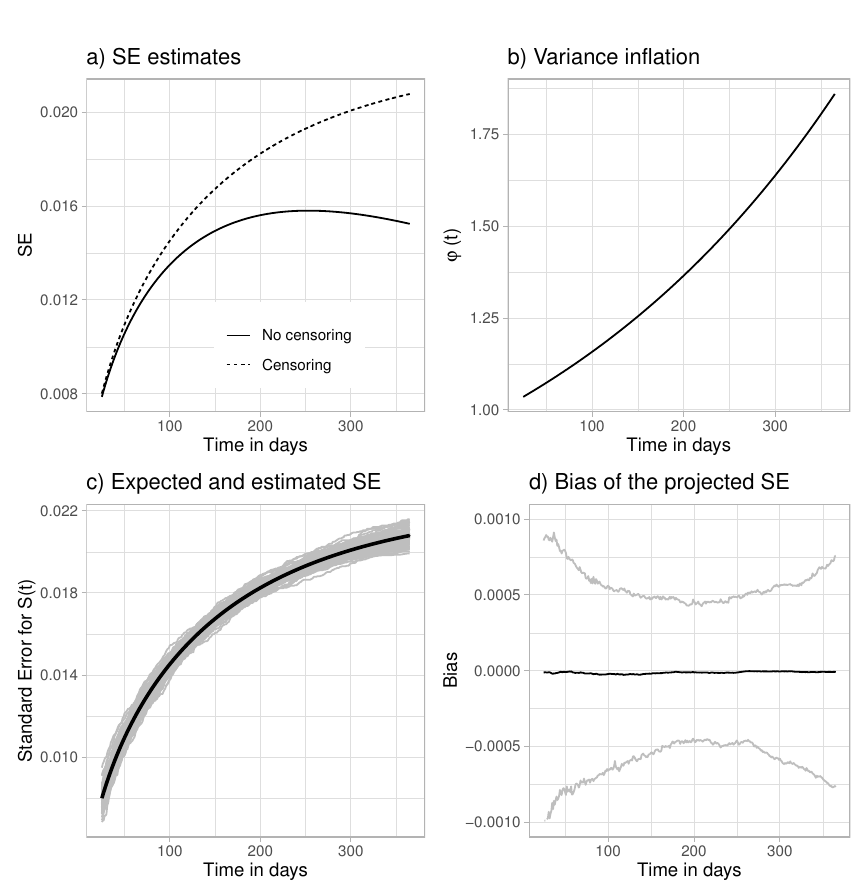
Figure 1 – Results of a simulation study assuming exponential survival and censoring times depict- ing (a) the expected SE for the survival curves with and without censoring, (b) the time dependent variance inflation due to censoring, (c) the expected (thick black) and estimated (thin grey lines) SE of the survival curve and (d) the bias of the projected SE with 95 % Monte Carlo confidence